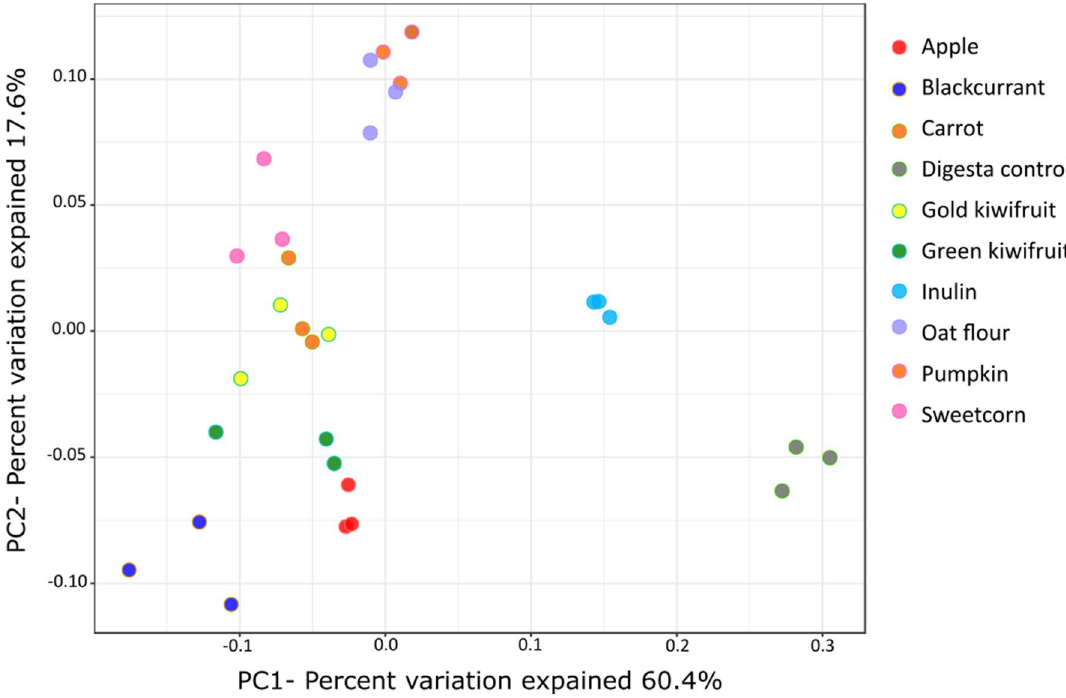
Figure 4. Bray–Curtis similarity index-based Principal Coordinate Analysis plot of the infant gut microbiome demonstrating the shifts in the community structure after 10 h of fermentation of the different foods in comparison to the no-carbohydrate digesta control. Each fermentation was carried out in triplicate.